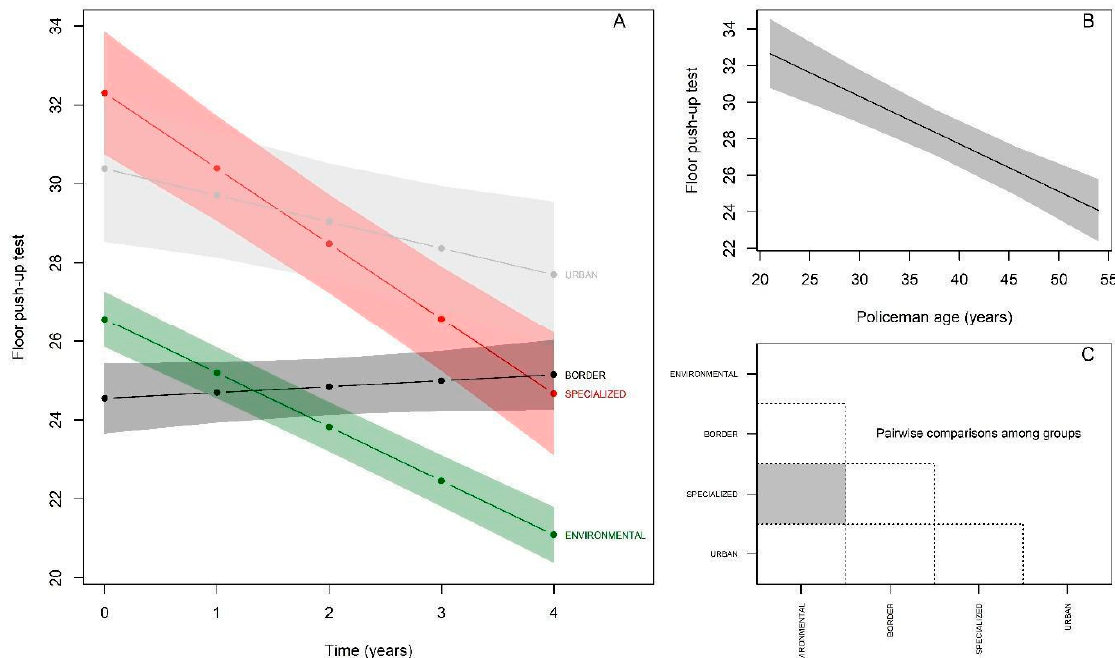
Figure 4. Performance behavior of police officers—Push-ups. ( A ): Change in maximal floor push-up repetition performance over 5 years by police specialties; ( B ): Performance in maximal push-up repetitions by police officers in relation to age; ( C ): Comparison of test performance between police specialties at baseline (gray color indicates significant difference between respective groups). Table 4. Statistical summary and model-estimated coefficients of the effect of group, time, and age on performance in the floor push-up test.